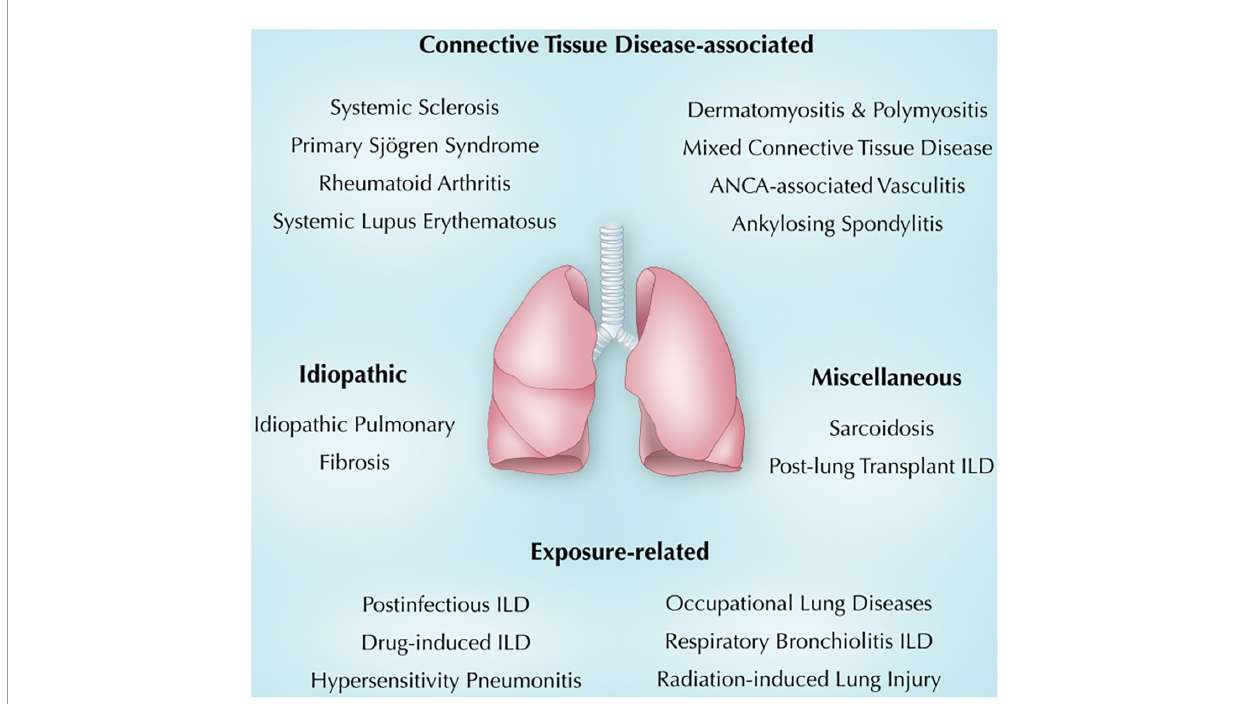
FIGURE1 Overview of immune-mediated lung diseases discussed in this review. ANCA, anti-neutrophil cytoplasmic antibodies; ILD, interstitial lung disease.